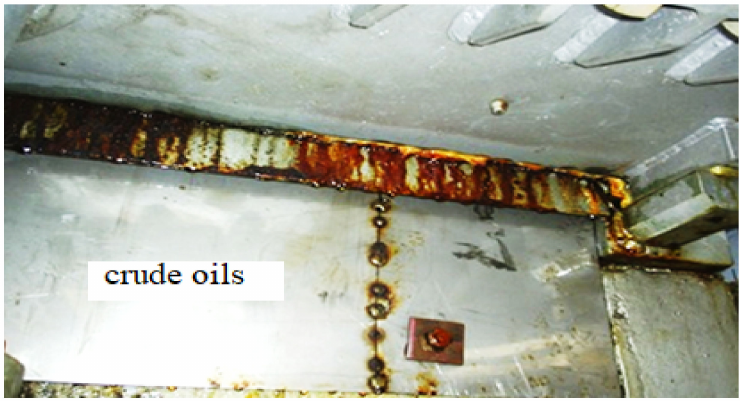
Figure 2. Corrosion in the reflux vessel (photo by Timur